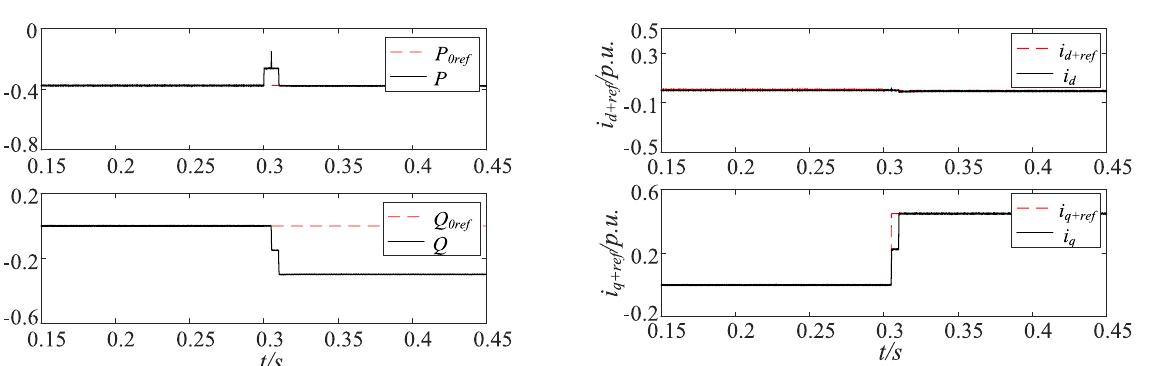
Fig. 15 Power waveform when the voltage drops in the inverter state